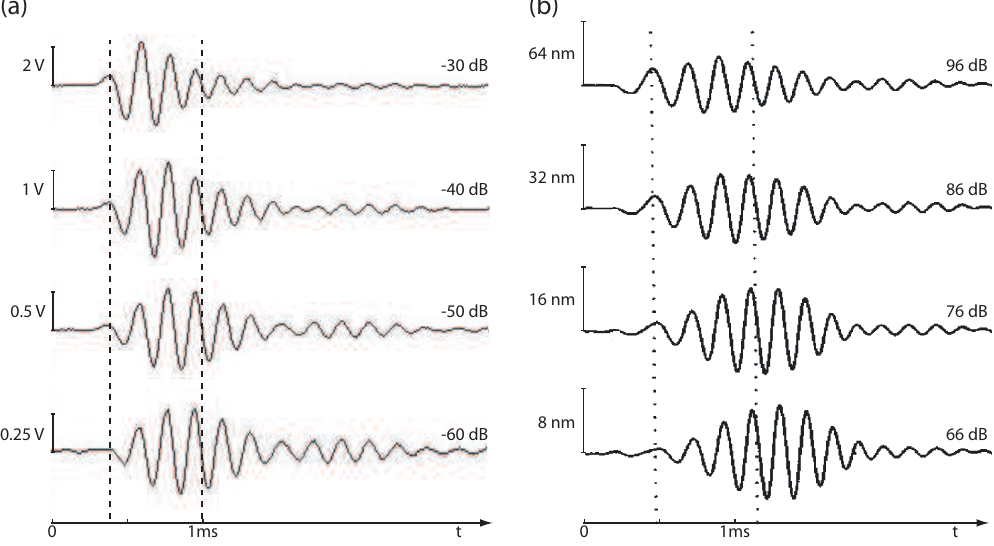
Figure 5 . Response to broadband transient stimulation (clicks): a) hardware ( µ = − 0 . 05 , central fre- quency: 5 kHz), b) biology (chinchilla, central frequency: 5.5 kHz, adapted from